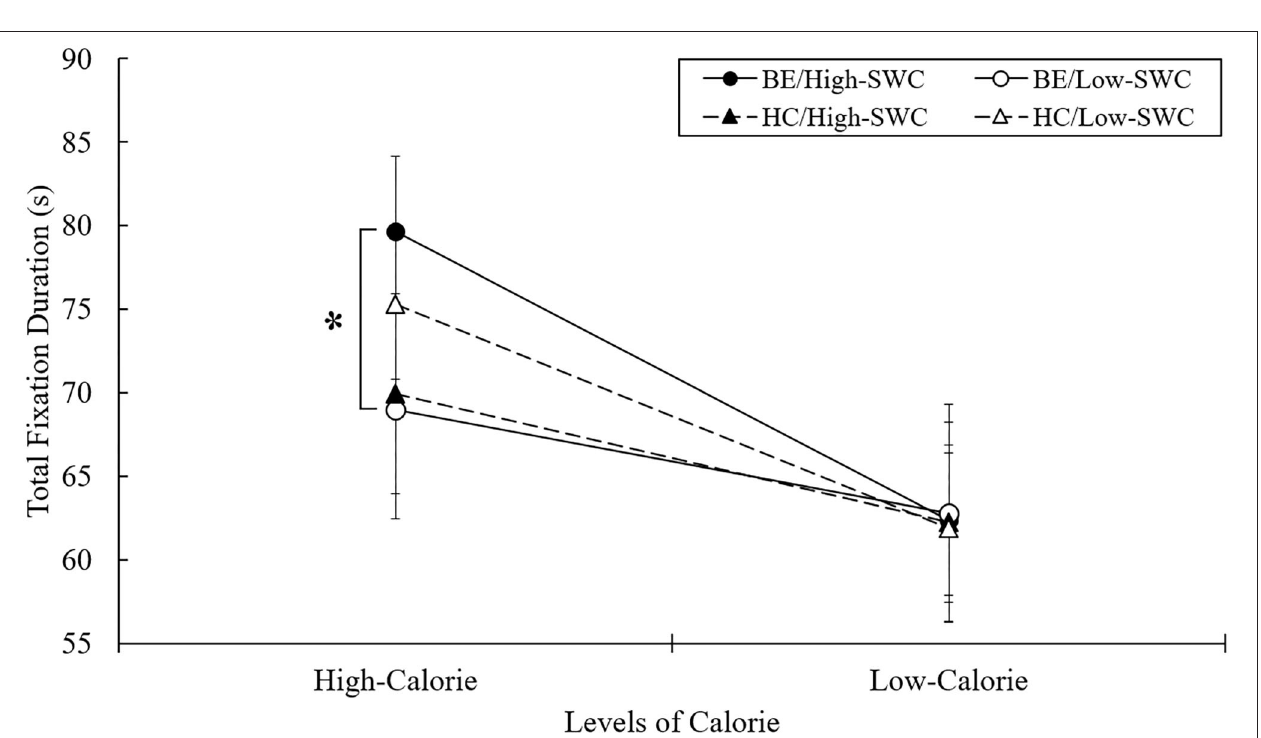
FIGURE 3 | Mean total fixation duration in free-viewing task. BE, binge eaters; HC, healthy controls; SWC, shape/weight concern. * p < 0.05.